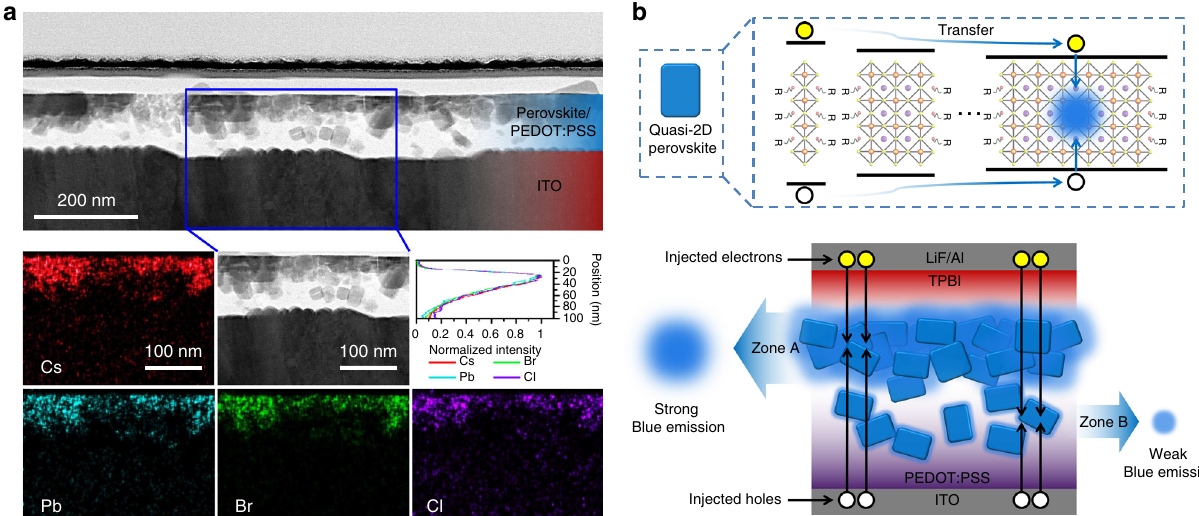
Fig. 4 Vertical morphology of the perovskite thin fi lm and schematic diagram of the modulation of recombination zone position. a Cross-section scanning transmission electron microscope (STEM) image of a indium tin oxide (ITO)/PEDOT:PSS/perovskite fi lm. Energy-dispersive spectrometer (EDS) measurement was also used at the region marked with the blue lines to illustrate the elemental distribution of Cs, Pb, Br, and Cl. The position versus normalized intensity curves illustrate the integrated intensity of the Cs, Pb, Br, and Cl signals as a function of depth. The perfect overlapping suggests the homogenous distribution of all four signals in perovskite crystals. b The top schematic diagram shows that each perovskite crystal is in a quasi-2D structure, and energy transfer and/or charge transfer occurs after the injection of electrons and holes. The bottom schematic diagram shows that as most of the perovskite crystals disperse at the top of the fi lm, if the injected electrons and holes can recombine in Zone A, a strong blue emission can be obtained; however, if the injected electrons and holes can only recombine in Zone B, the fi lm shows a weak blue